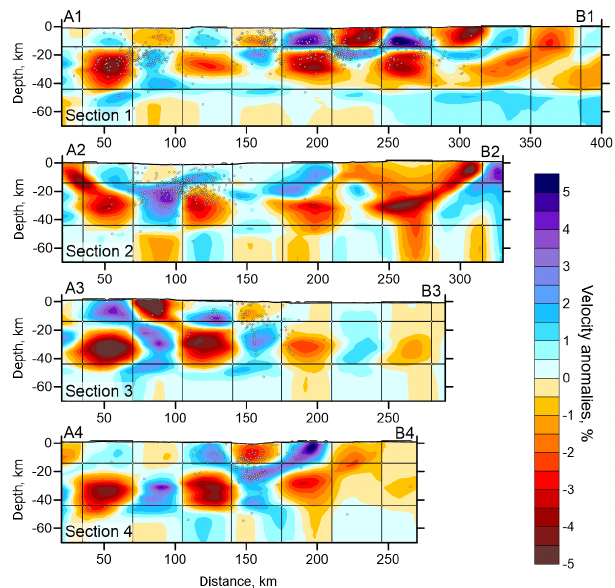
Figure 5. Checkerboard tests with the model changing the sign of anomalies at 20km depth. Here, only P velocity anomalies are shown. Locations of the sections are shown in Fig. 2. Thin black lines indicate the configurations of the “true” synthetic patterns. Dots depict projections of seismic events located at the vicinity of the profile.